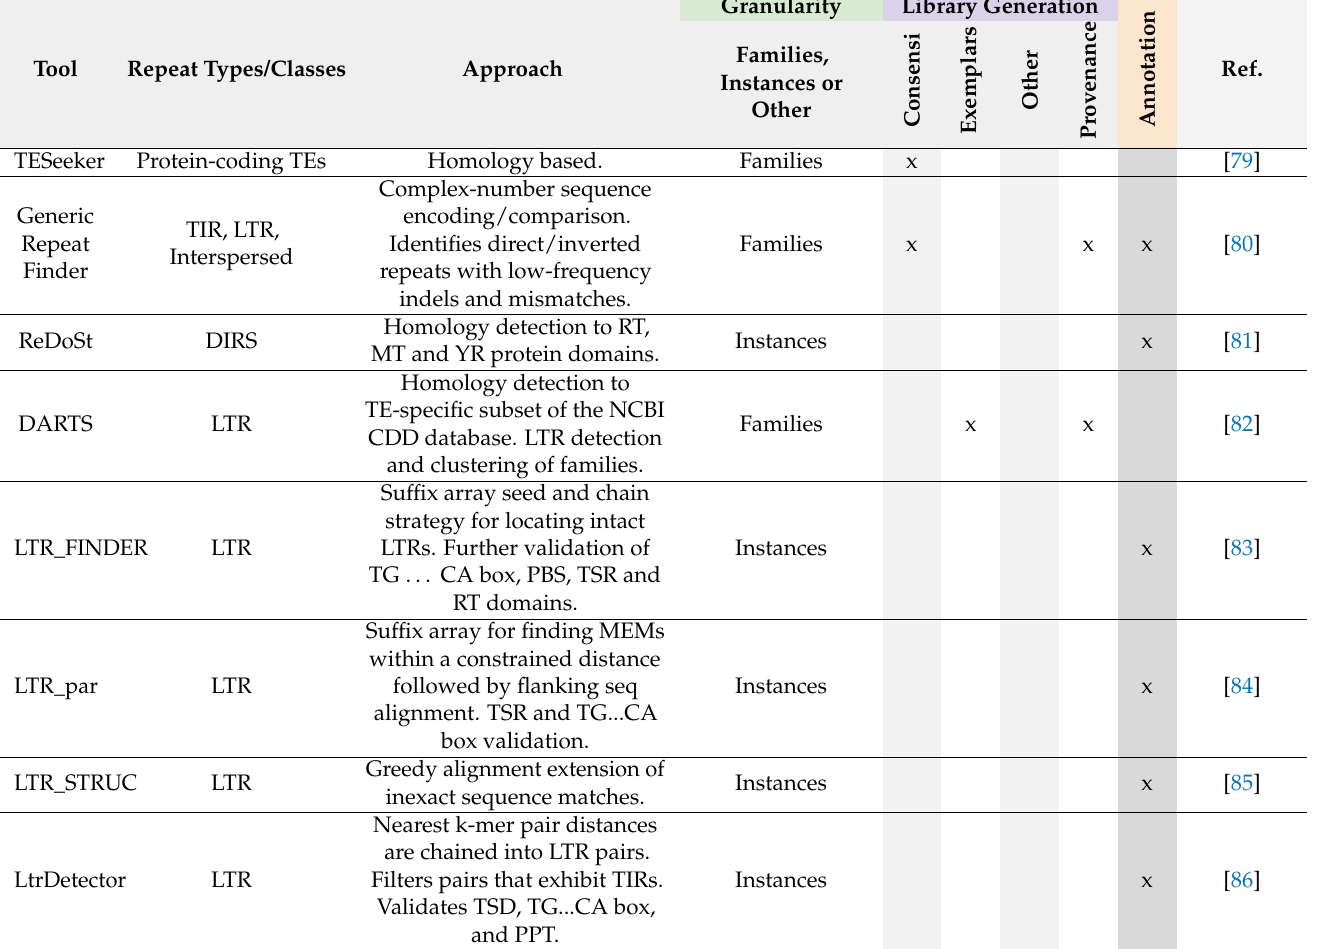
Table 2. Signature-based